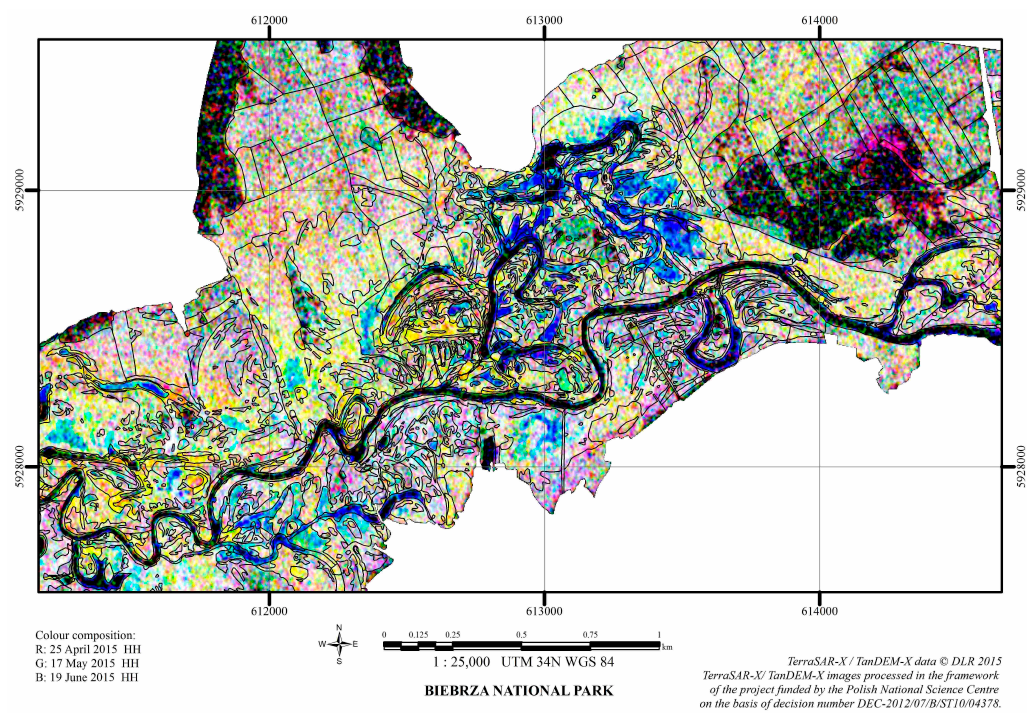
Figure 7. The RGB color composition of the coherence change based on TSX/TDX images acquired at HH polarization, taken on the 25 April 2015, 17 May 2015 and 19 June 2015 respectively. High values of the SE (cid:2900) component, which means a high degree of phase randomness, were observed over open water and dense vegetation (grass). High values of SE (cid:2893) and low values of SE (cid:2900)